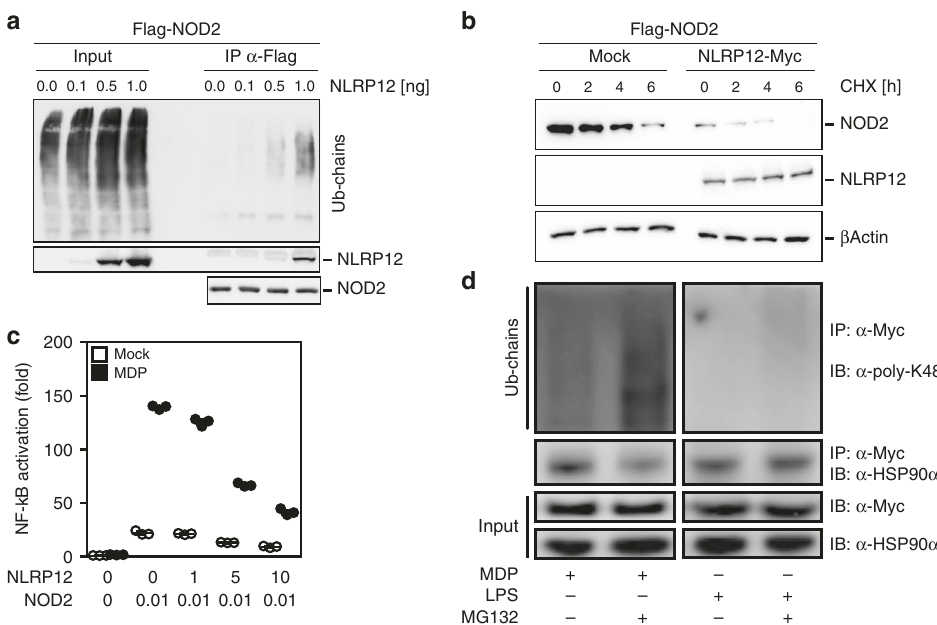
Fig. 2 NLRP12 suppresses MDP-induced NF- κ B activation by targeting the NOD2/RIPK2 complex for assembling of K48 poly-ubiquitin chains on NOD2 and subsequent degradation. a Western blot analysis of NOD2 ubiquitination in HEK293T cells that were transfected with FLAG-tagged NOD2 in the presence of increasing amounts of NLRP12 as indicated. b Western blot analysis of NOD2 stability in the presence of cycloheximide (CHX at 20 μ g/mL) for 4 h. HEK293T cell extracts were subjected to western blot analysis for FLAG-tagged NOD2, Myc-tagged NLRP12 and β -actin. c NF- κ B-Luciferase activity in HEK293T cells normalized to expression of β -galactosidase. Depicted are mean ± SEM ( n = 3). d Immunoblot analysis of poly-K48 ubiquitination on NOD2 and of HSP90 α / β following co-immunoprecipitation with NOD2 by using the anti-Myc antibody in THP-1 Myc-BirA*-NOD2 cells that were stimulated with MDP (10 µ g/mL; left panel) or LPS (0.2 µ g/mL, right panel) for 2 h with or without MG132 (12.5 µ M)